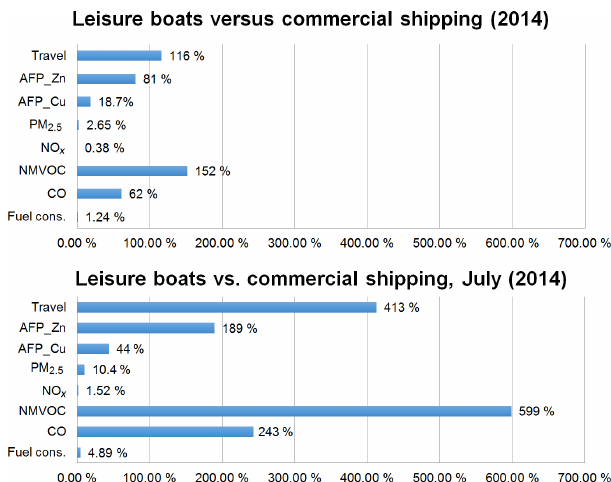
Figure 11. Modeled leisure boat emissions, fuel consumption (kg) and travel kilometers with respect to those of the commercial fleet in 2014 and separately for July 2014. A value of 100% indicates an equal contribution from small boats and commercial